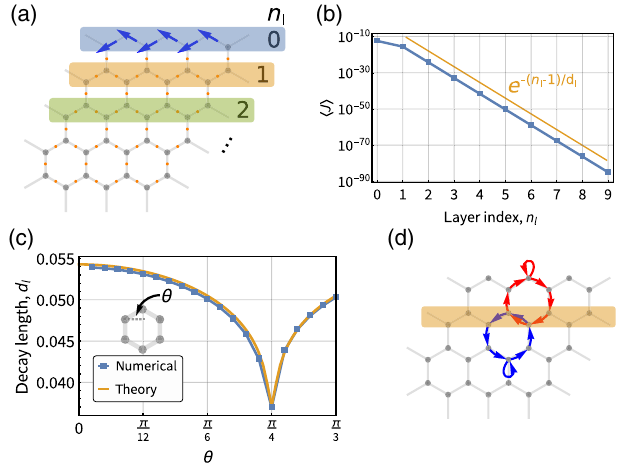
FIG. 9. Decay of fluxes away from the boundary of honeycomb networks, and explanation using the diagrammatic technique. (a) Schematic of a honeycomb network that is periodic in the x direction. Layers from the boundary are indexed as n . l (b) Semilog plot of flux h J i at layer n . The flux starting from l 1 shows exponential decay, with decay length d layer n . l ¼ l Parameters used for numerical calculations are θ ¼ π = 6 , k=k 0 ¼ 0 . 01 , α ¼ π = 4 . (c) Decay length d , which changes with l the network angle θ nonmonotonically, and the curve, which has a cusp at θ ¼ α ¼ π = 4 . At small k=k 0 , perturbation theory results agree with numerical calculations. (d) The first nonvanishing 1 with length 7. The two diagrams do not diagram pair for n l ¼ cancel because the loop in the bulk and that at the boundary have different